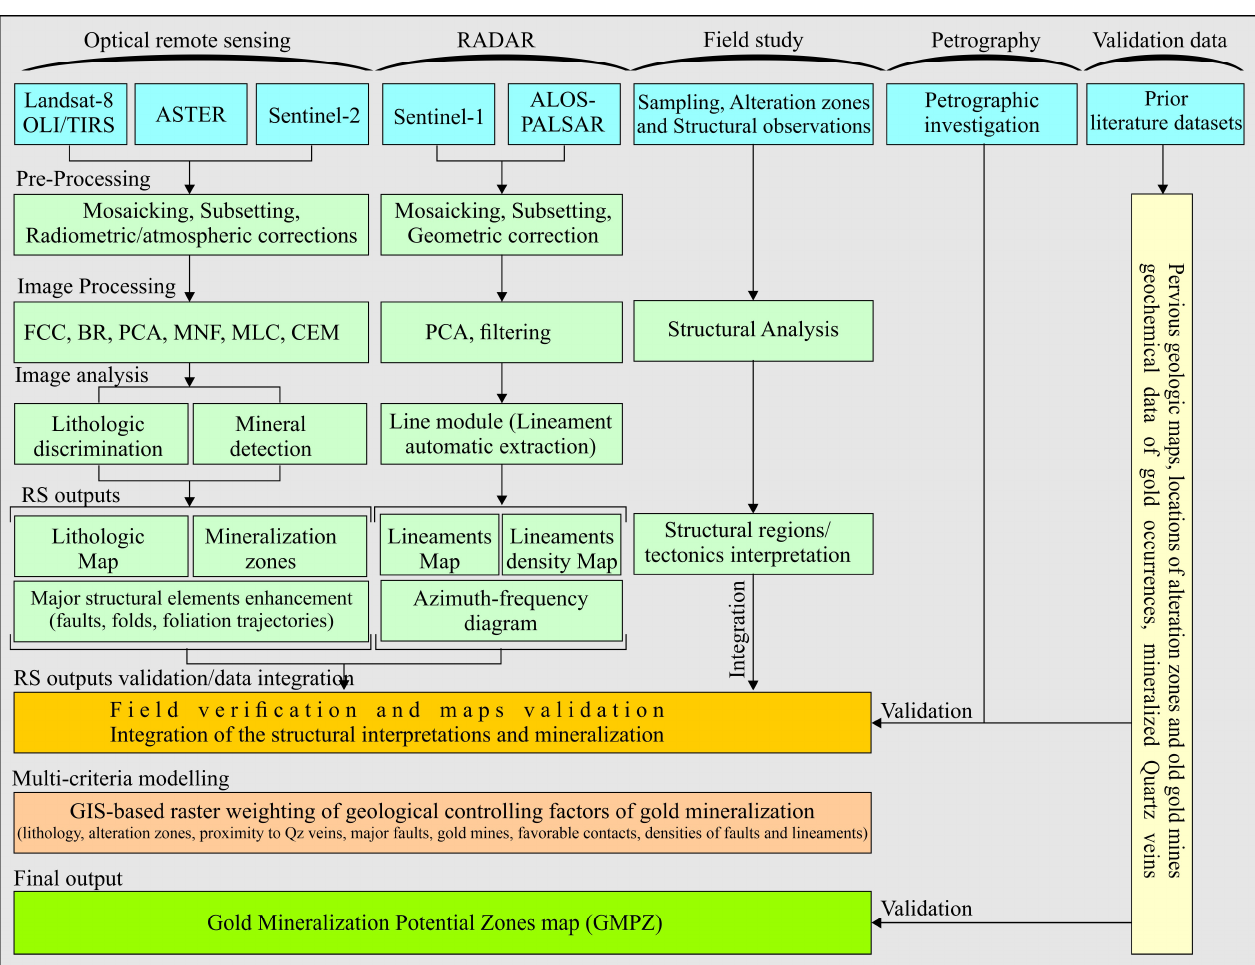
Figure 4. The data and methodology adopted in the present